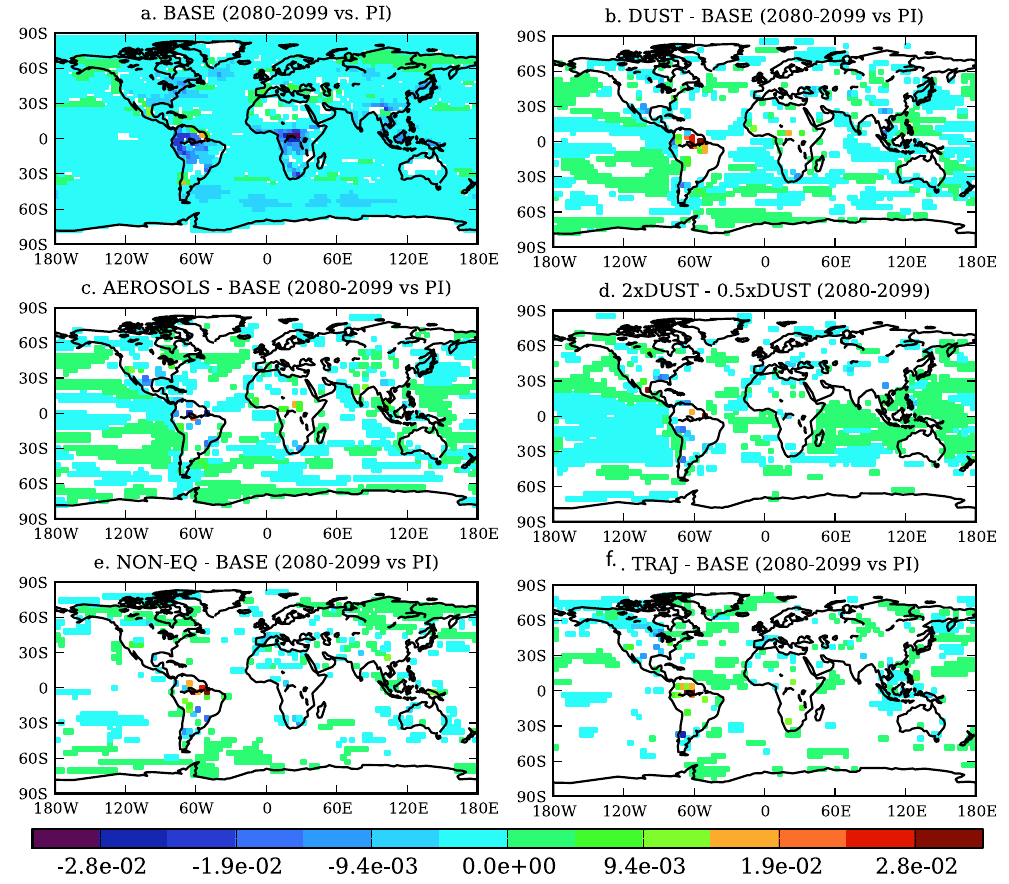
Fig. 10. Same as Fig. 8, but for CO 2 fluxes (mg CO 2 m − 2 s − 1 ). Carbon fluxes are positive upwards into the atmosphere. A negative value would indicate that less carbon is going into the atmosphere during 2080–2099 than during the